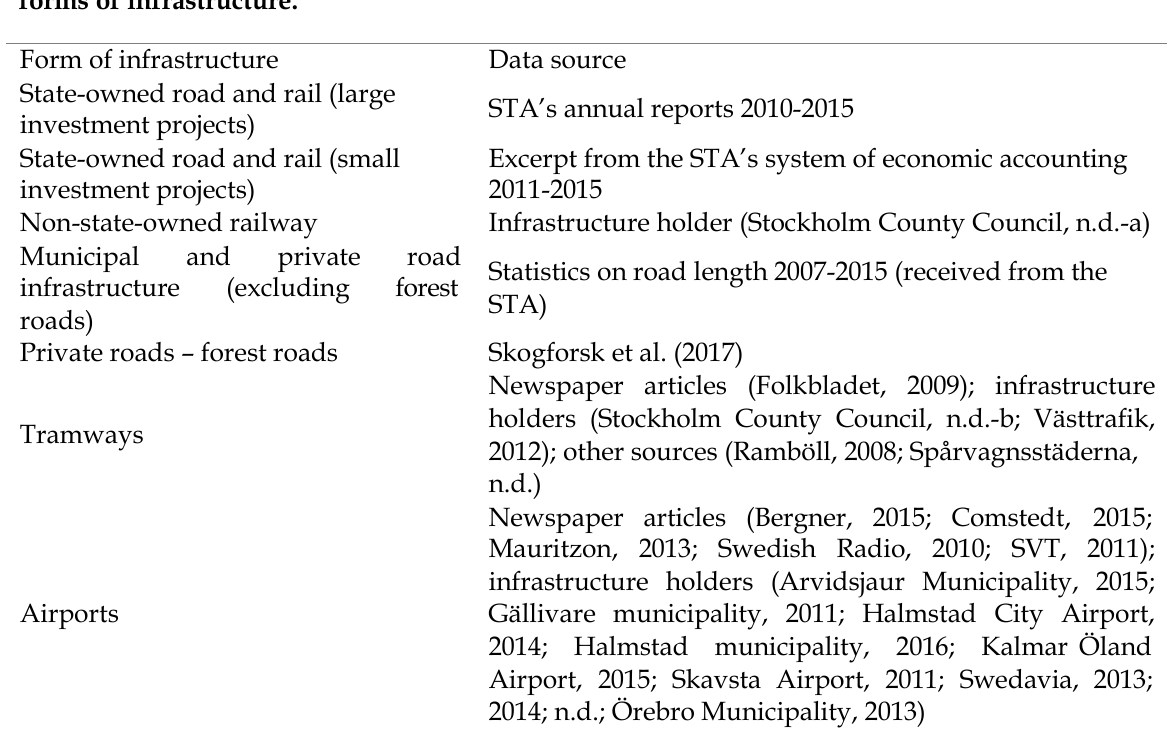
Table 3. Data sources used to compile a list of new construction projects for different forms of